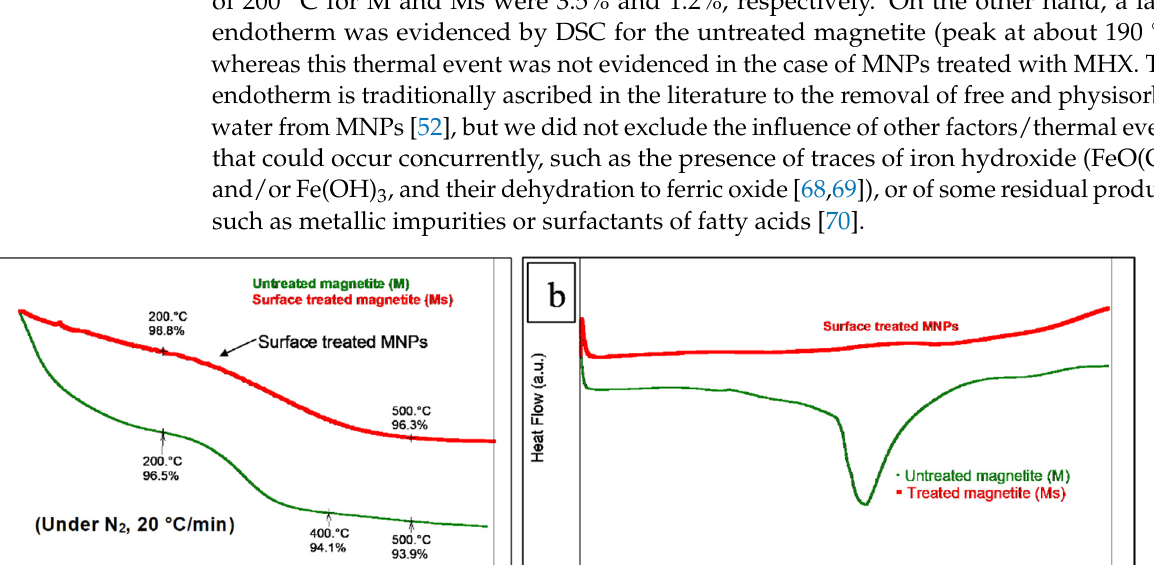
Figure 1. Thermogravimetric (TG) and derivative thermogravimetric (D-TG) curves of MHX with a different thermal history (under N 2 , 20 °C/min).